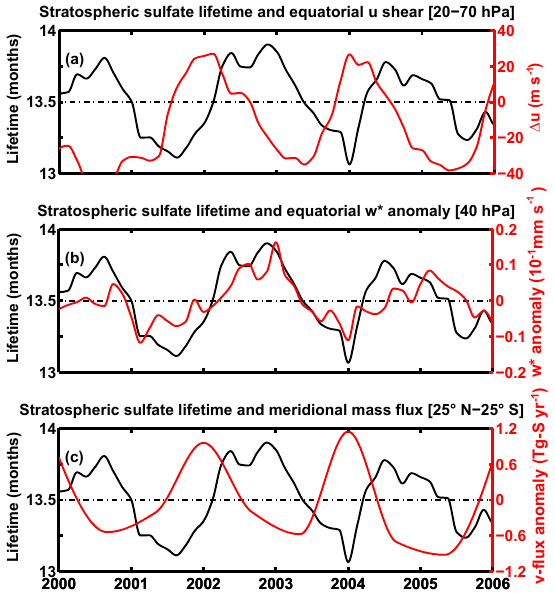
Figure 6. As in Fig. 5 but for GEOS-Chem for the years 2000–2005. The calculated average lifetime of stratospheric sul- fate from geoengineering sulfur injection of 8TgSO 2 yr − 1 is 13.5 ± 0.3 months in GEOS-Chem (equatorial residual vertical ve- locity w ∗ = 0.14 ± 0.06mms − 1 , as a time average between 20 and 70hPa; net poleward meridional sulfate flux out of the tropical pipe (cid:56) V = 2.31 ± 0.38TgSyr − 1 , as a time average at 25 ◦ S and 25 ◦ N latitude above the tropopause). The monthly variability in the sulfate lifetime (0.3 months) is smaller than in ULAQ-CCM (1.2 months) but closer to the latter when the ULAQ model is op- erated in CTM mode (0.6 months), i.e., using the Base circulation for the G4 case, without including the aerosol radiative feedback on dynamics (see text).